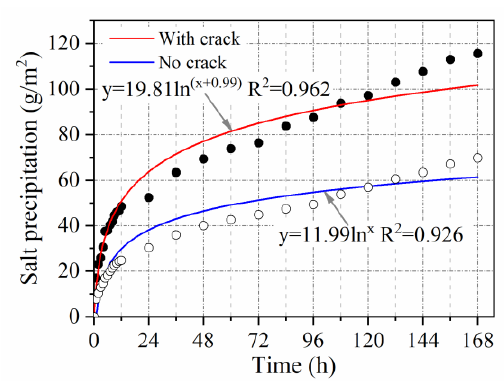
Figure 16. Effect of cracks on salt precipitation.